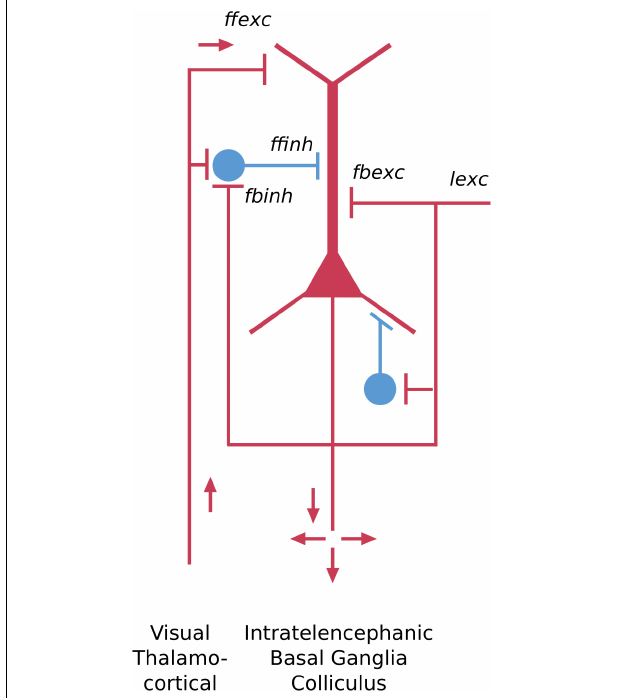
FIGURE 3 | Basic pyramidal cell (principal cell) forms the cortical circuit module of three-layer cortex in the turtle dorsal cortex. Red indicates excitatory, blue indicates inhibitory cell. ffexc , feedforward excitatory; fbexc , feedback excitatory; lexc , lateral excitatory; ffinh , feedforward inhibition; fbinh , feedback inhibition [Adapted from Shepherd and Rowe